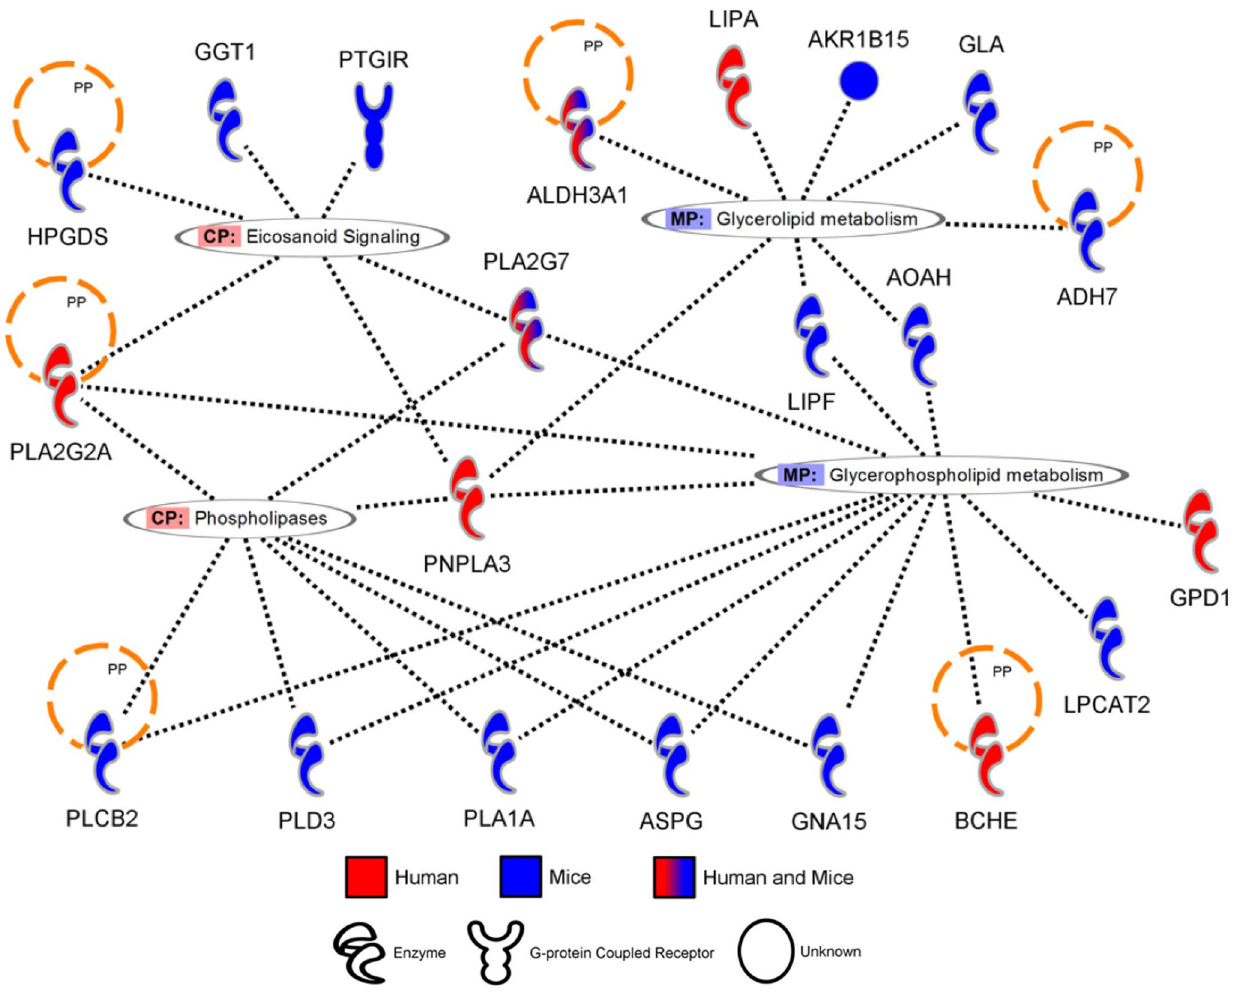
Figure 3. Genes associated to ‘‘Phospholipid metabolism/degradation’’ pathways modulated by cigarette smoke exposure in humans and mice. Orthologue genes significantly upregulated in humans and/or mice (fold change . 2) were used to predict canonical pathways activated by cigarette smoke exposure. Diagram generated using the Ingenuity Pathway Analysis Software.